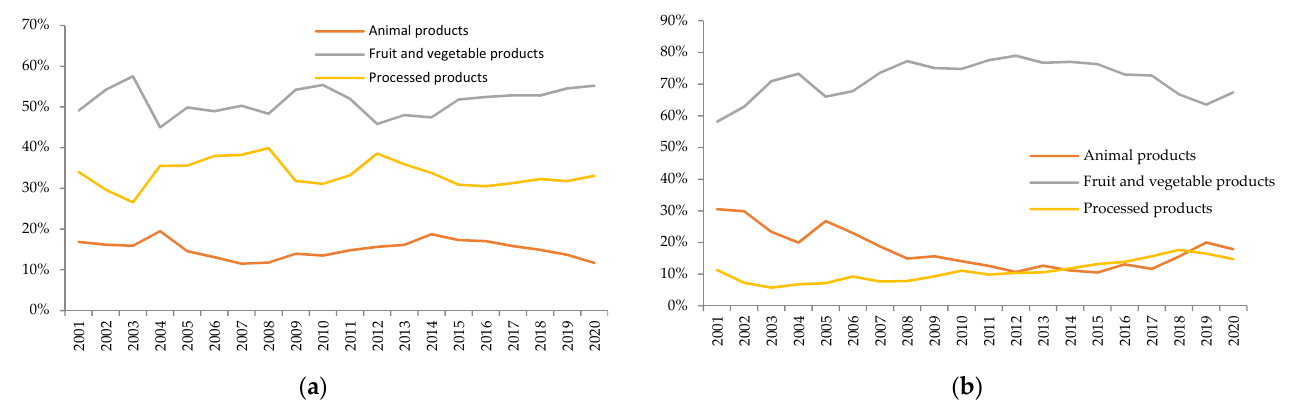
Figure 3. ( a ) China exports agricultural to B&R countries product distribution; ( b ) China imports agricultural to B&R countries product distribution. Data Source: UN COMTRADE database.